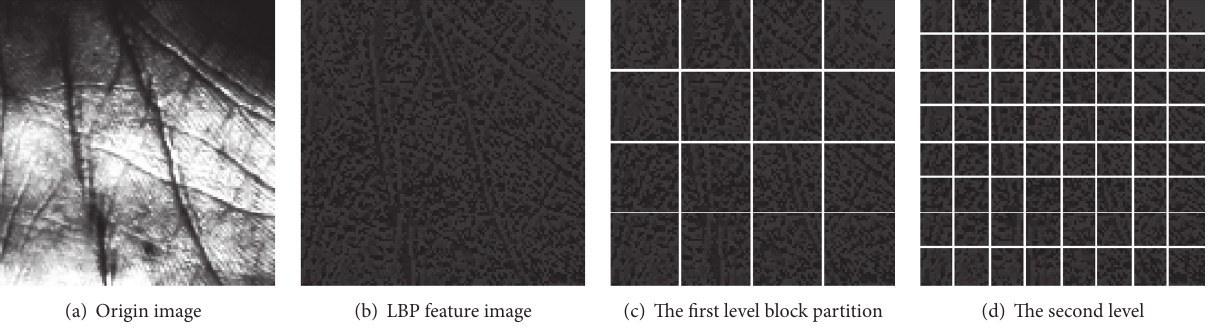
Figure 3: Hierarchical diagram of the LBP.